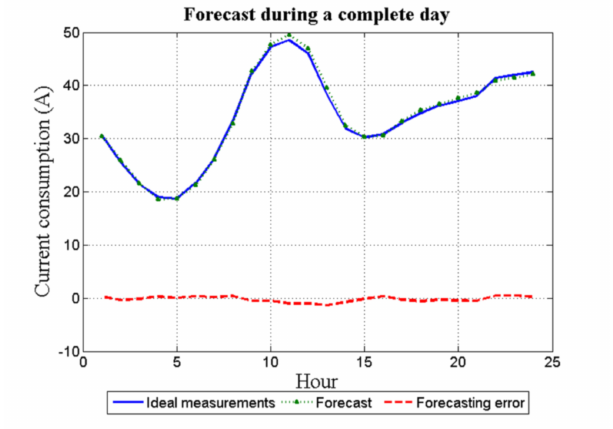
Figure 7. Simulated EIT—forecasting error for one-day